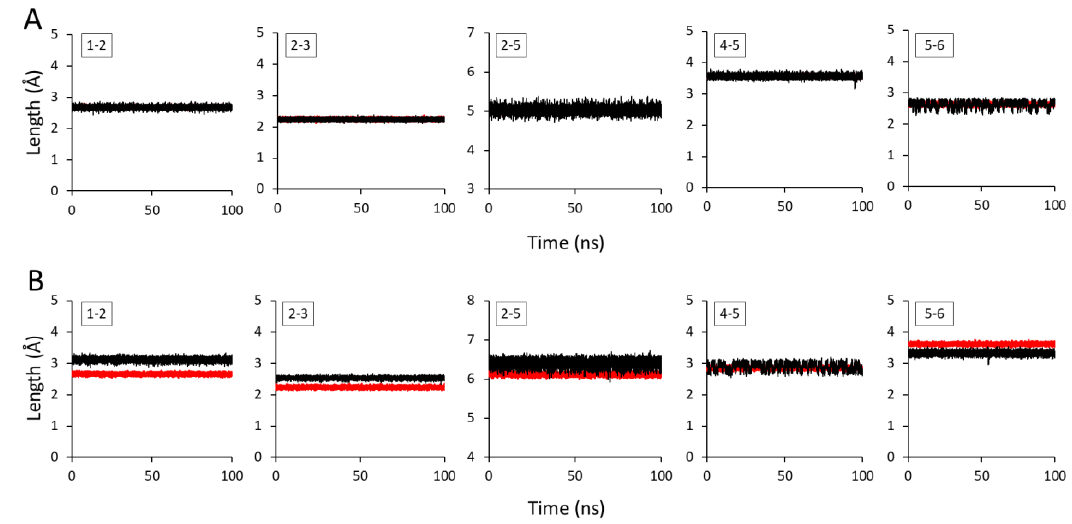
Figure 2. Bond lengths of all-atom (AA) and coarse-grained (CG) representations for ( A ) HA1-3 and ( B ) HA1-4. Black and red lines indicate AA and CG representations, respectively.